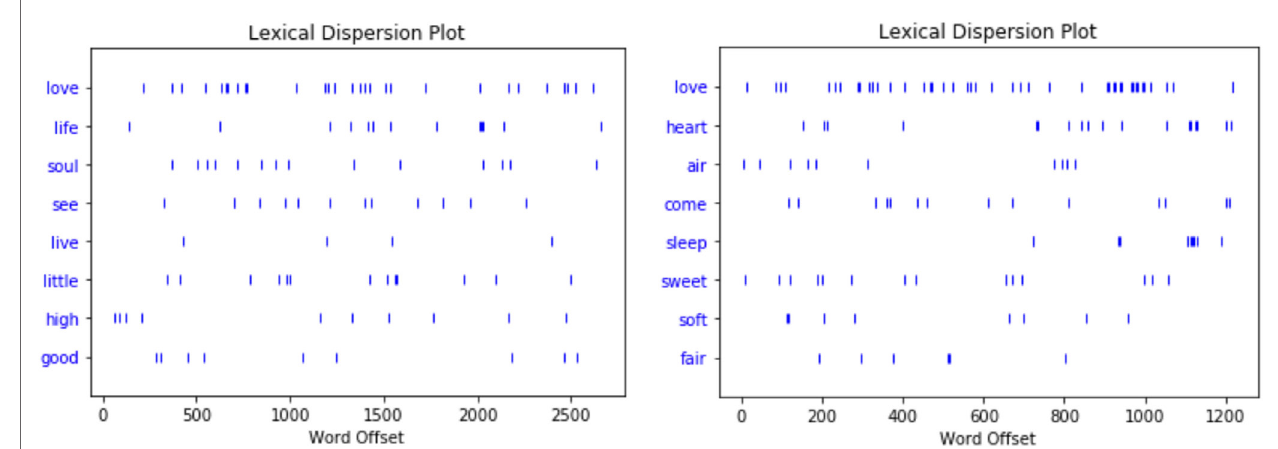
FigUre 3 | Lexical dispersion plots for the three most frequent nouns, verbs, and adjectives in George Eliot’s poem “How Lisa Loved the King” (right panel) and James Joyce’s “Chamber Music” (left panel). Note that the word “love” is counted as both noun and verb